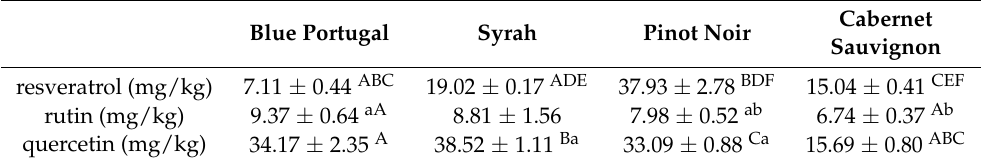
Table 1. Polyphenol content (mg/kg dry weight) of grape seed pomace of four different grape varieties harvested in the Vill á ny wine region. Blue Portugal